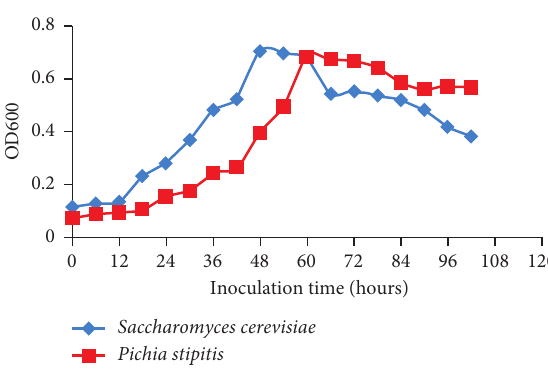
Figure 3: The growth curves of Saccharomyces cerevisiae and Pichia stipitis .